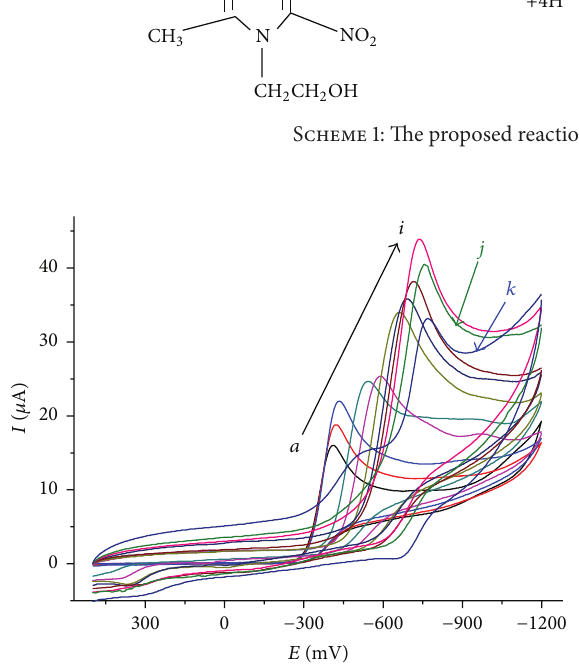
Figure 3: Cyclic voltammograms of 1mM MTZ in BRB solution of different pH values ( a – k : 2.0, 2.5, 3.5, 4.0, 4.5, 5.0, 6.0, 6.5, 7.0, 7.5, and 8.0, resp.). Scan rate: 100 mV/s.